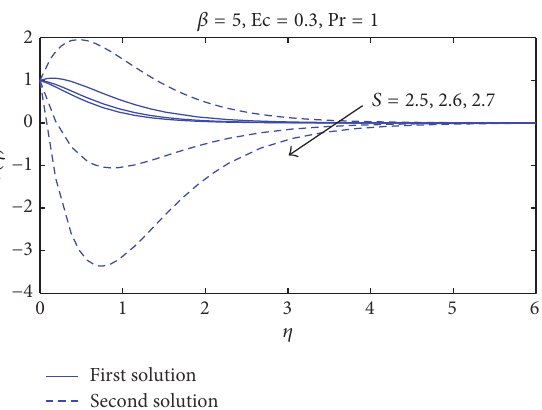
Figure 10: Temperature profiles for different values of Ec.